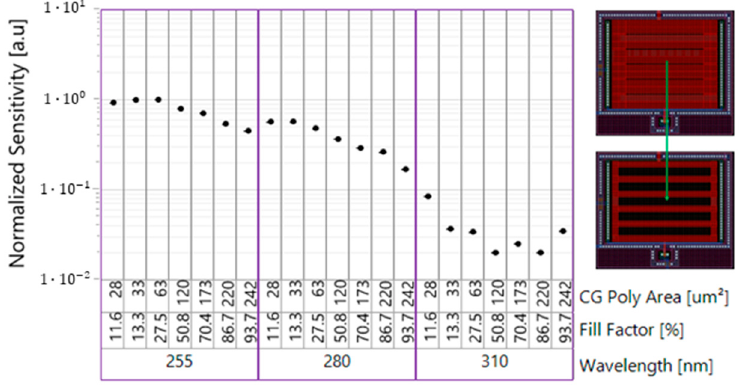
Figure 9. Grill C-Sensor normalized sensitivity for different UV wavelengths vs. fill factor.